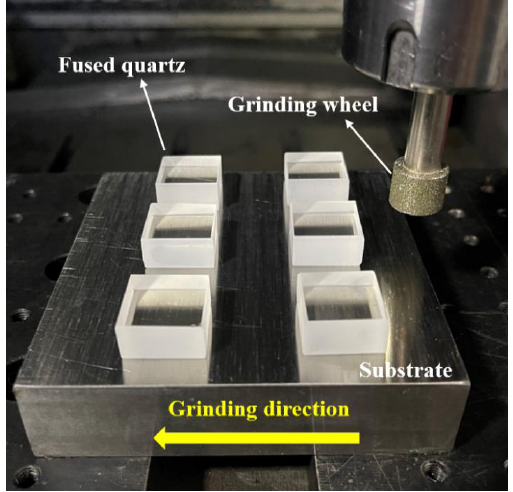
Figure 1. Schematic diagram of the experiment.